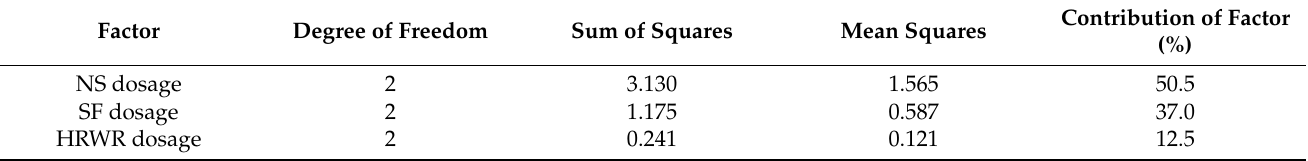
Table 10. Analyses of variance (ANOVA) for compressive strength.